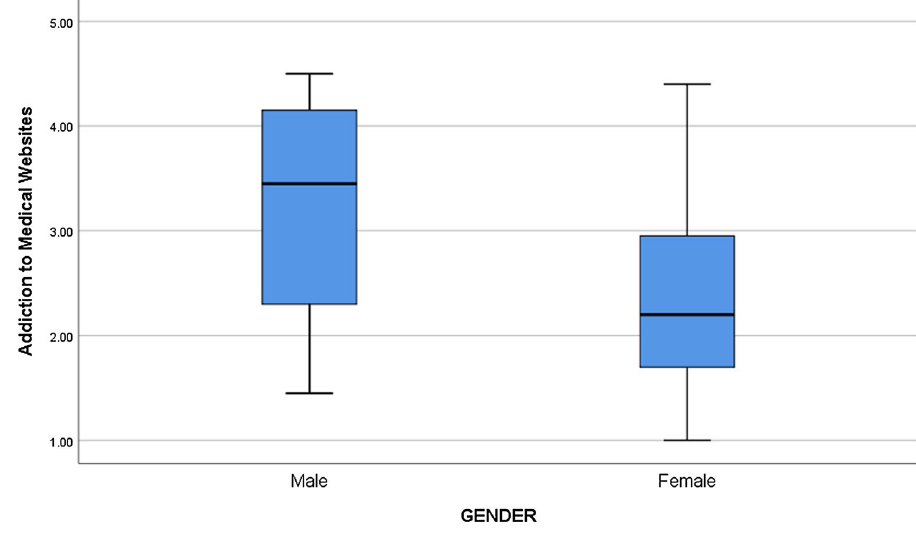
Fig. 3 Boxplot of the means and SDs of hypochondria based on